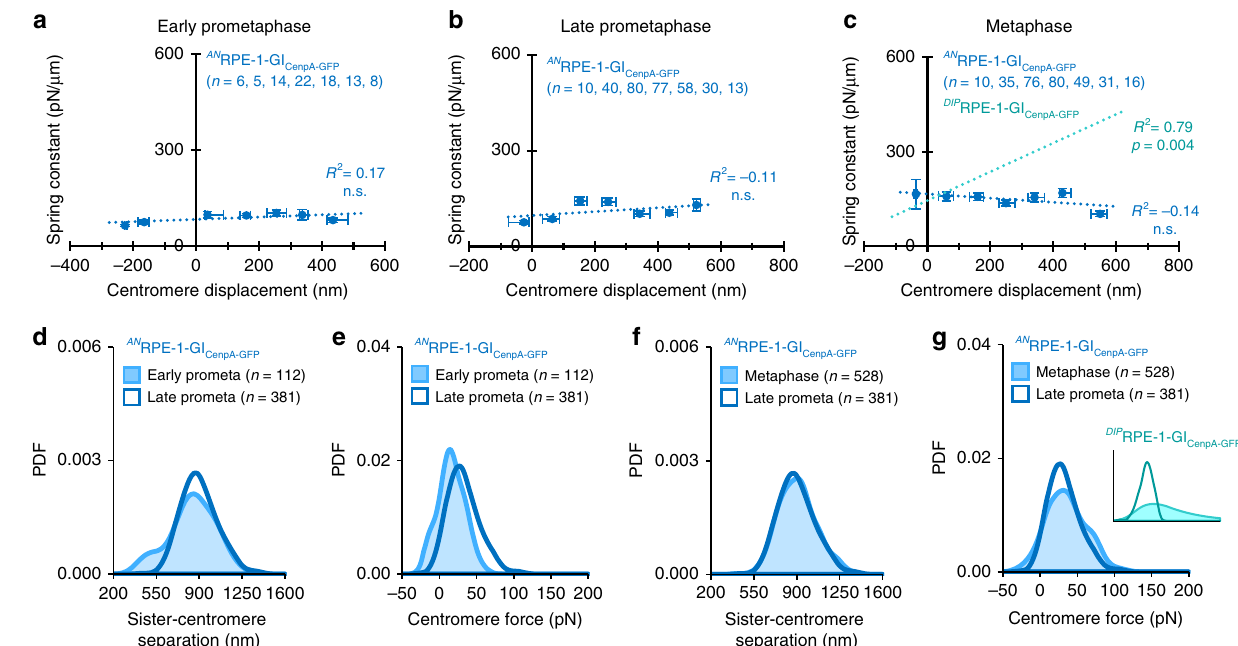
Fig. 9 Disrupted centromere mechanical maturation dampens metaphase tension. a – c Relationship between the displacement of the centromere-spring and its spring constant at early-prometaphase ( a ), late-prometaphase ( b ), and metaphase ( c ) for aneuploid RPE-1-GI cells. Chromosomes were subgrouped by displacement in 100 nm intervals starting at the group minimum. Only subgroups with four or more chromosomes are shown. Each data point re fl ects the subgroup ’ s median displacement and mean spring constant; X -axis error bars represent IQR; Y -axis error bars represent standard error. The least-squares regression fi t is indicated by the dotted line and the listed R 2 value. Exact p values from linear regression fi t are shown for models meeting statistical signi fi cance; all others are indicated as non-signi fi cant (n.s.). The least-squares regression fi t line for diploid RPE-1-GI chromosomes at metaphase is shown for comparison ( c , dotted green line). d , e Probability density functions for individual observations of d sister centromere separation and e centromere force at early-prometaphase (light gray line, shaded area) and late-prometaphase (black line) for aneuploid RPE-1-GI cells ( AN RPE-1-GI). f , g Probability density functions for individual observations of f sister centromere separation and g centromere force at late-prometaphase (dark blue line) and metaphase (light blue line, shaded area) for aneuploid RPE-GI cells. Inset: Centromere force distributions at late-prometaphase (dark teal line) and metaphase (light teal line, shaded area) from diploid RPE-1-GI cells ( DIP RPE-1-GI) are shown for comparison. See also Supplementary Figs. 5 and 7. All n